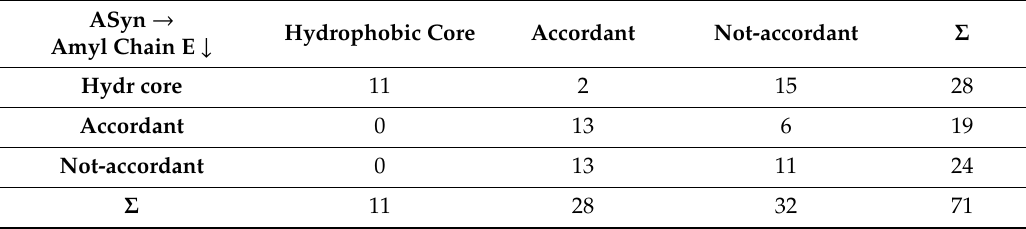
Table 3. Status (number) of residues involved in the construction of the hydrophobic nucleus (Hydr core), showing the status in accordance with the fuzzy oil drop model (Acc.) and incompatible with the fuzzy oil drop model (Not accordant). The columns express the status in micelle-bound ASyn, rows—the string treated as an individual